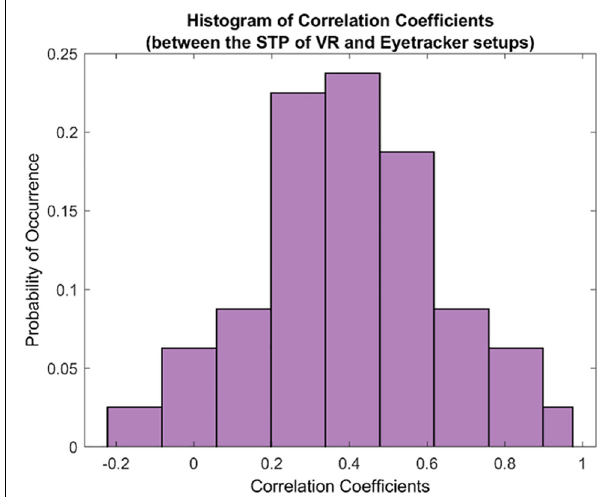
FIGURE 5 | The histogram of correlation coefficients between the 80 STPs of the VR and the eye tracker setups. The unimodal histogram is centered around 0.4 ± 0.24. Fifty-three of the total 80 STPs were found to be significantly correlated across the two setups (see Supplementary Table 6 ).